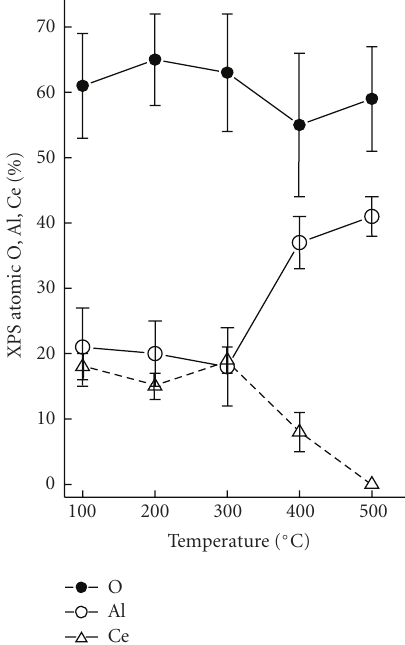
Figure 3: Evolution of composition with temperature for the La- treated surface.